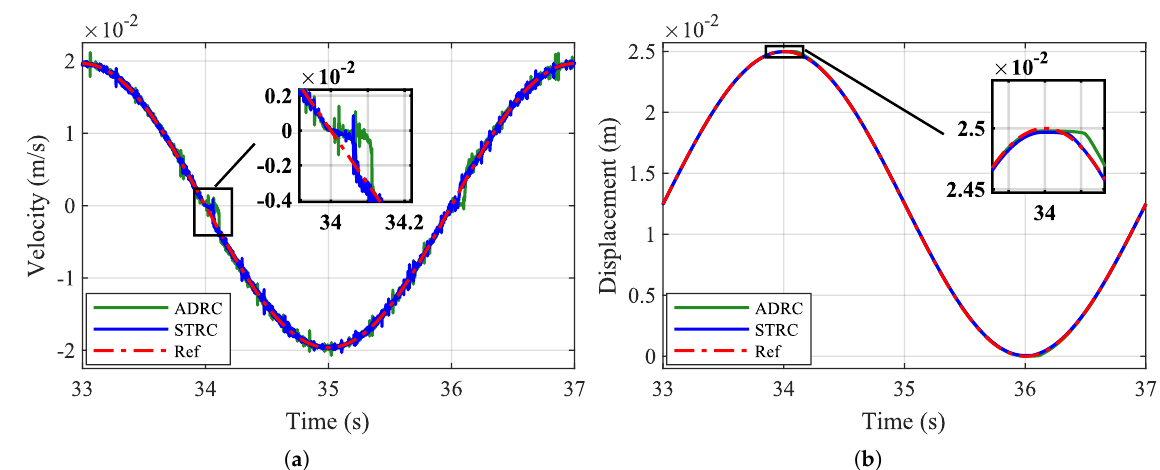
Figure 16. Experimental waveform comparison at 0.25 Hz. ( a ) Velocity; ( b )